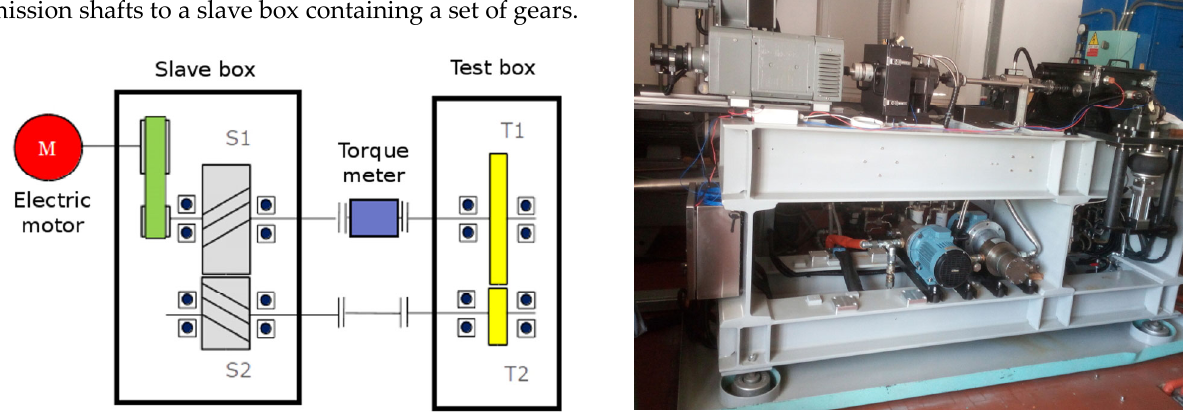
Fig. 9 Schematic of twin disc machine. Fig. 10 Image of twin disc